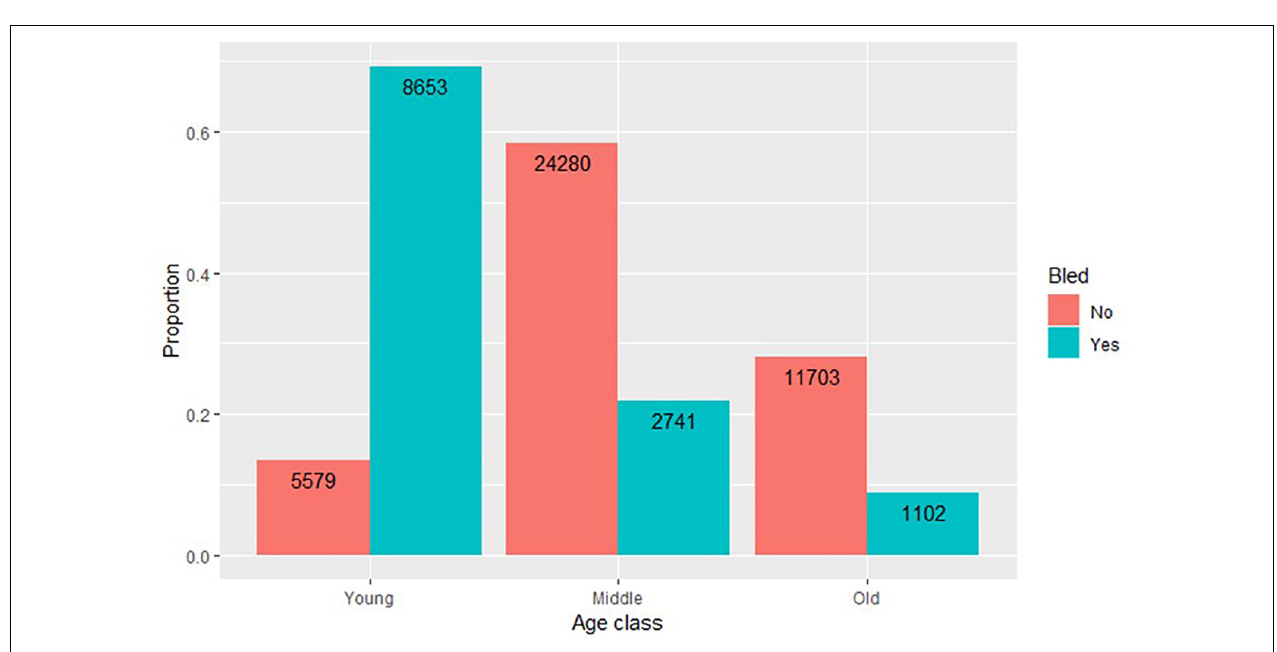
FIGURE 4 | Apparent survival of horseshoe crabs tagged and released in the coastal Delaware to Virginia areas (cf Figure 1 ) from 2008 to 2017. Estimates with 95% confidence intervals from the candidate model with minimum AICc, which binned time into 2-year periods, are plotted.